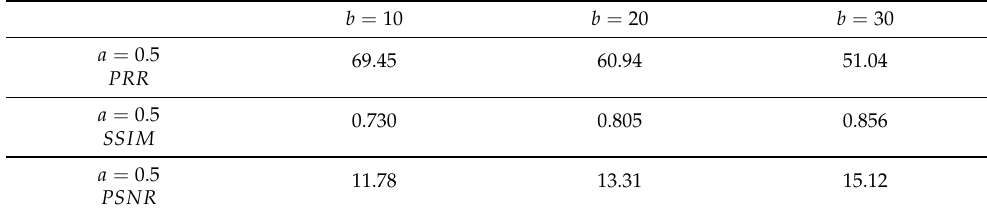
Figure 8. Lena resulted image I new for a = 1 and b = [20:10:40]. Table 5. Baboon image without HE for a =